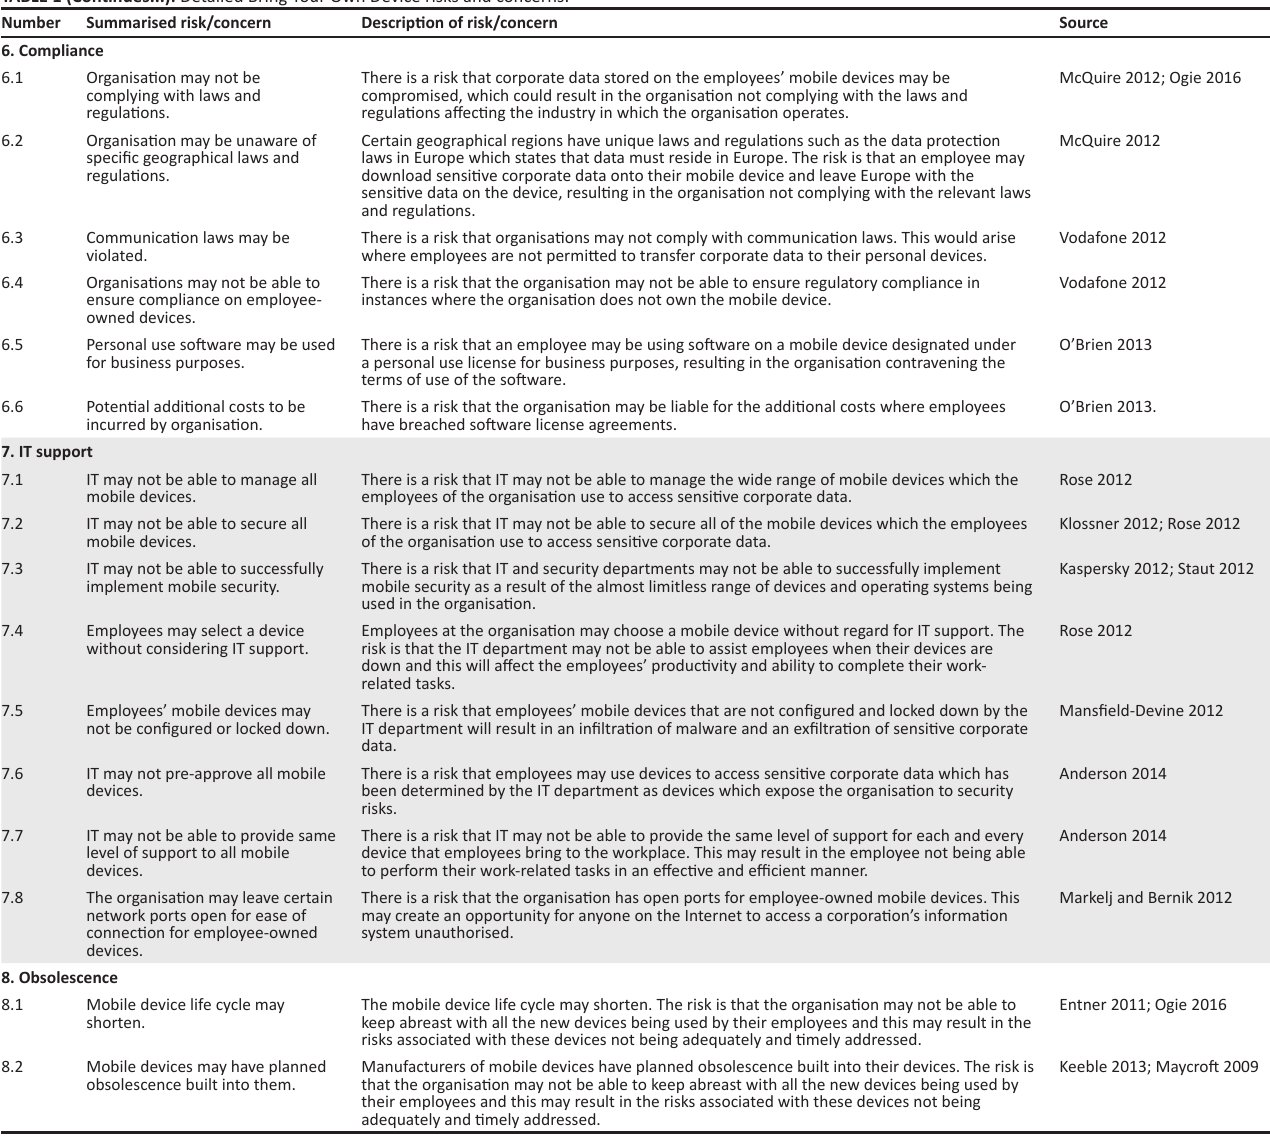
TABLE 1 (Continues...): Detailed Bring Your Own Device risks and